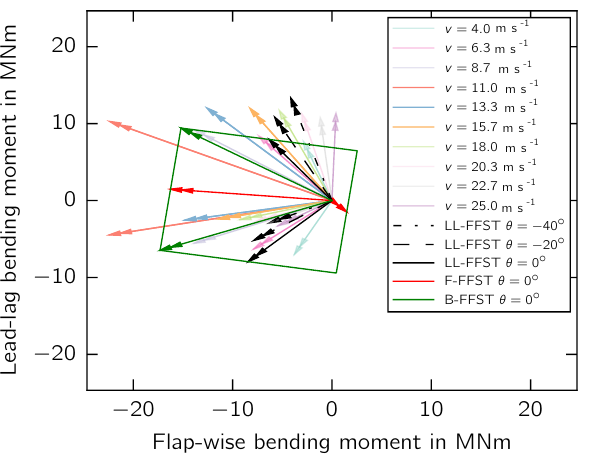
Figure 5. Moment vectors of lead–lag loading at different wind speed bins and in a lead–lag fatigue full-scale blade test (LL-FFST) at different pitch angles at 10% blade length. A flapwise FFST (F- FFST) and the bounding box of possible bi-axial FFST scenarios (B-FFST) are shown.